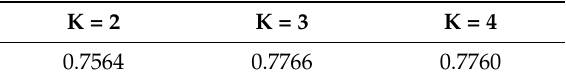
Table 1. Performance comparison among different parameter settings (k = 2, 3, 4) in the framework of